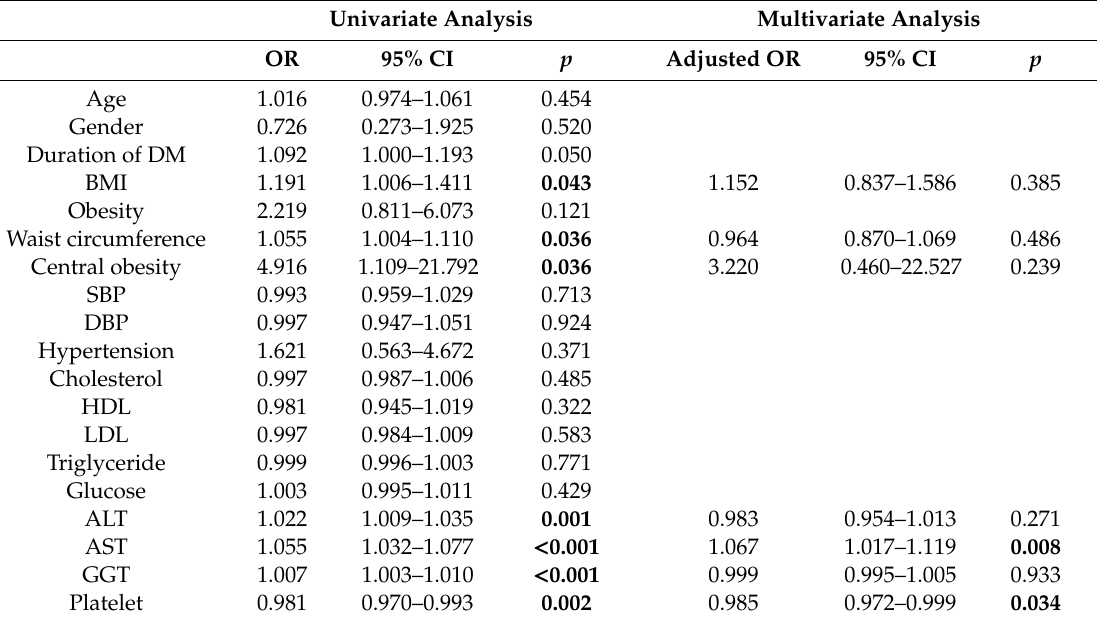
Table 3. Associations between the presence of advanced fibrosis on transient elastography and T2DM patients’ characteristics by univariate and multivariate logistic regression